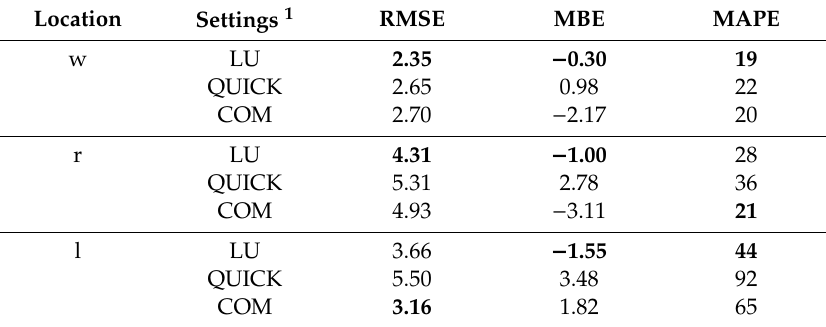
Table 7. Model root mean square error (RMSE), mean bias error (MBE), and mean absolute percent error (MAPE) for wind speeds at windward (w), ridgetop (r), and leeward (l) sensor locations at Big Southern Butte. Positive MBE indicates model over-prediction. Bold font indicates the lowest error at each location.